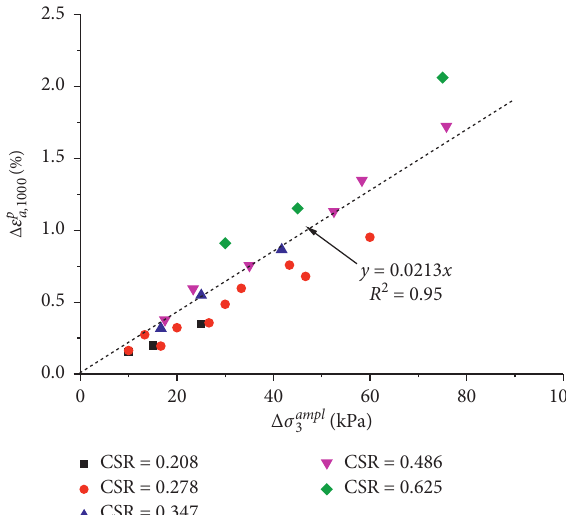
Figure 12: Relationships between the increment of permanent axial strain at N � 1000 versus the increment of amplitude of cyclic confining pressure.